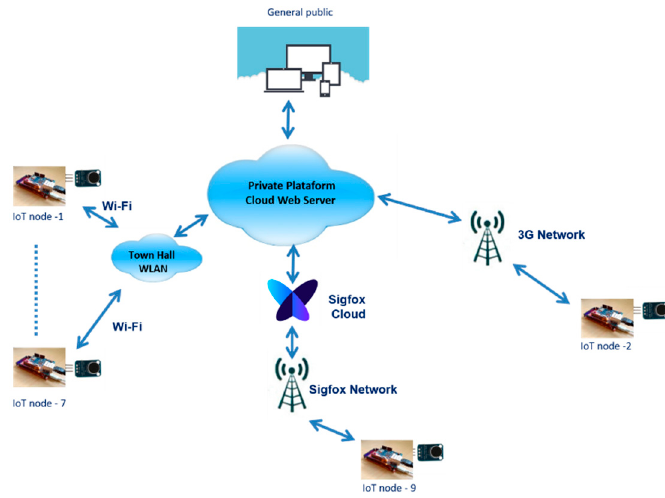
Figure 2. Sensors 2020 , 20 , x FOR PEER REVIEW